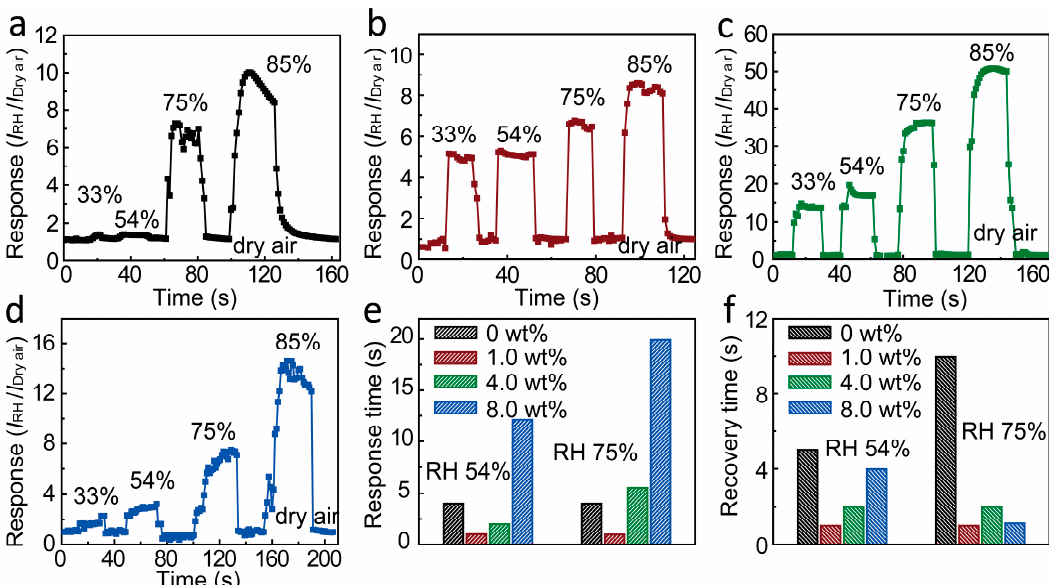
Figure 5. The response and recovery properties at DC 5 V with an Li doping level of ( a ) 0, ( b ) 1.0, ( c ) 4.0, and ( d ) 8.0 wt %, respectively, at different relative humidity values; The comparison of ( e ) the response time and ( f ) the recovery time of different Li + -doped SnO 2 PNFs at relative humidity levels of 54% and 75%, respectively.